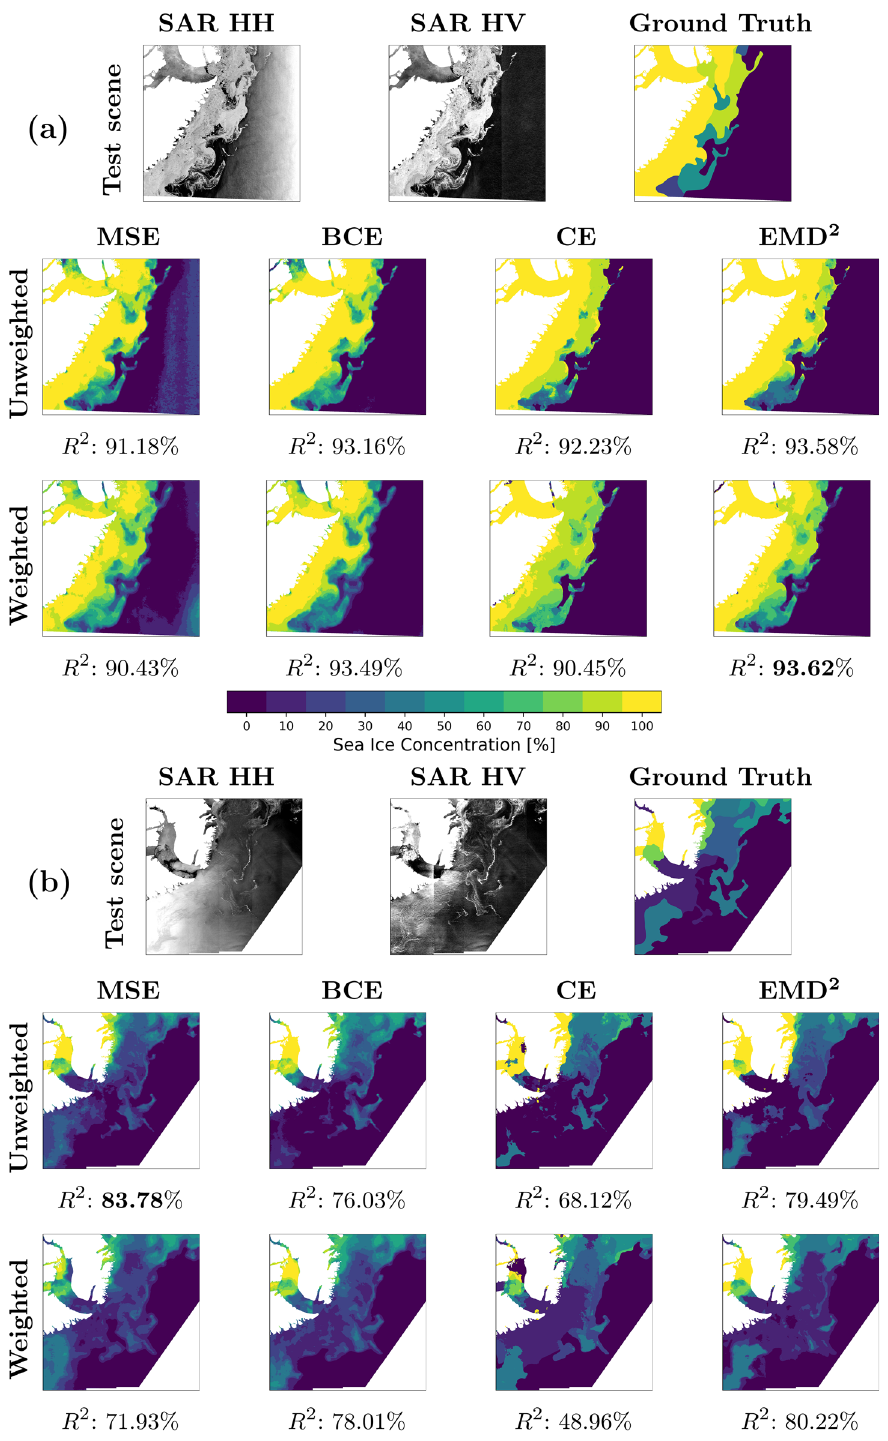
Figure 3. ( a ) Scoresbysund, East Greenland. Scene acquired May 9, 2019. ( b ) Scoresbysund, East Greenland. Scene acquired June 26, 2018. ( c ): Fram Strait, Northeast Greenland. Scene acquired September 3, 2018. ( d ): Fram Strait, Northeast Greenland. Scene acquired August 22,